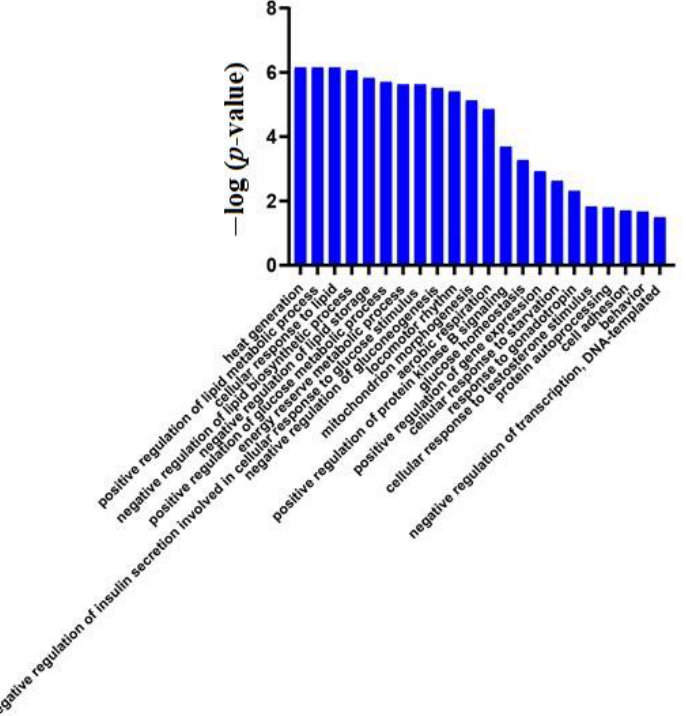
Figure 3. Biological processes enriched in differential proteins between week 1 and week 0 samples of the experimental group ( p < 0.05). Urinary Proteome Changes in the Whole Process Compared to W0, 51/69/86/65/88 proteins changed significantly at